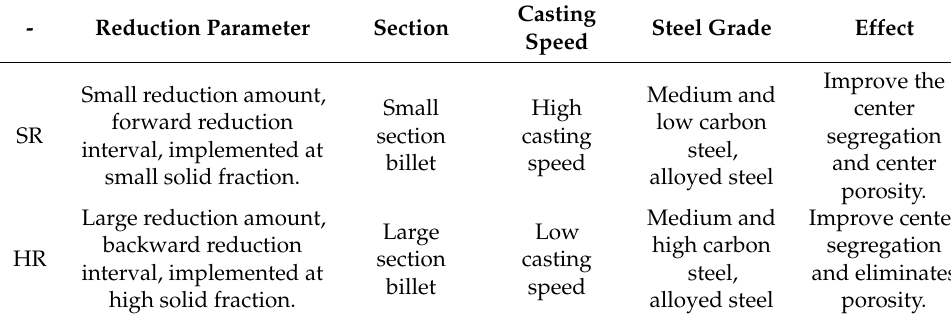
Table 5. Differences between HR and SR